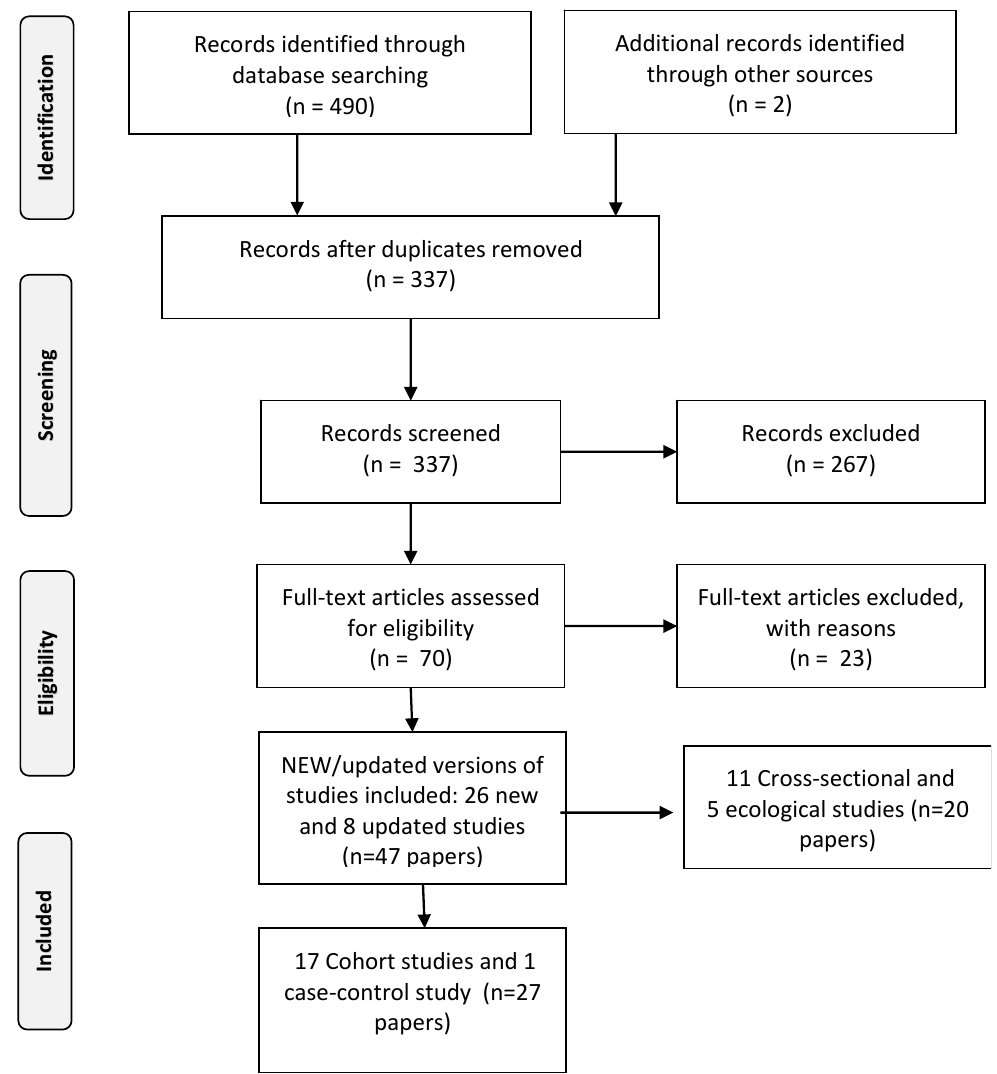
Figure 2. Flowchart outlining the study selection process for cardiovascular and metabolic effects.